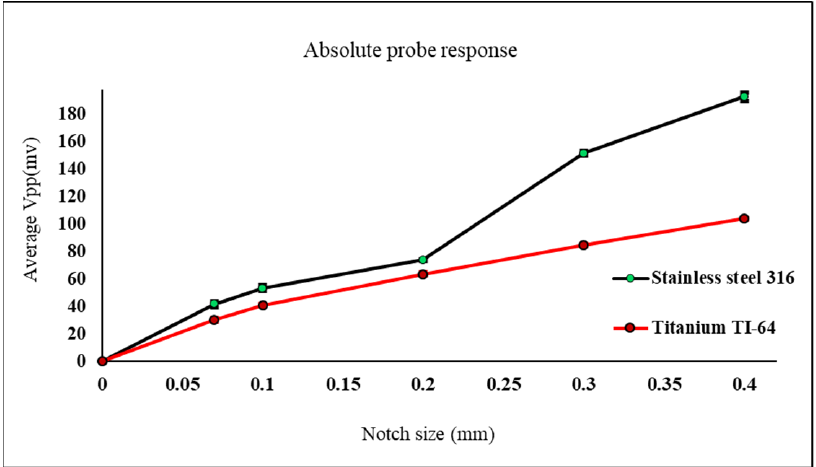
Figure 13. Measured Vpp values using absolute eddy current sensor on top of titanium and stain- less-steel samples with notches. steel samples with notches.